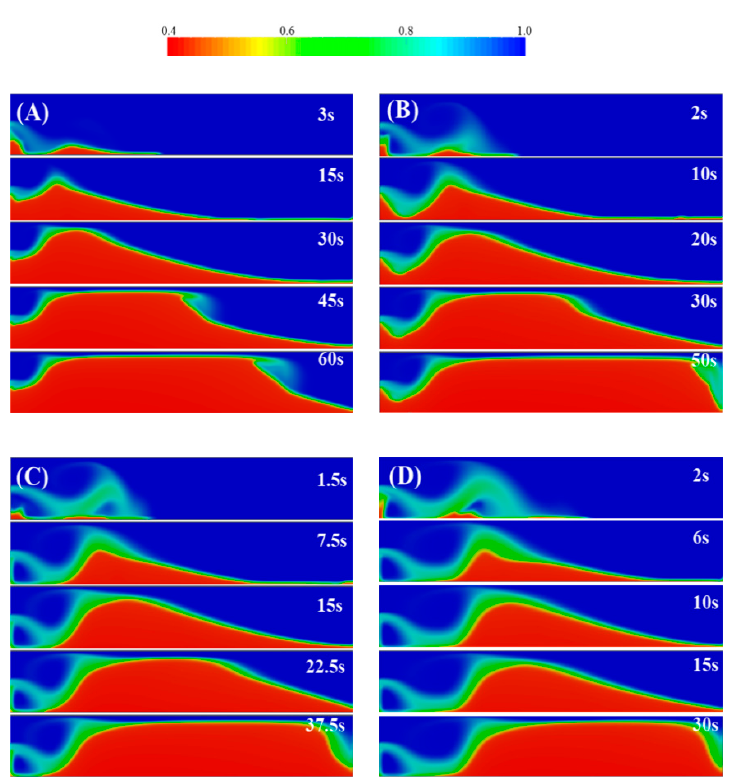
Figure 9. Volume concentration of liquid phase during the transport process for different injection A ) v = 2 m / s, ( B ) v = 3 m / s, ( C ) v = 4 m / s, and ( D ) v = 5 m / velocity cases: ( A ) v = 2 m/s, ( B ) v = 3 m/s, ( C ) v = 4 m/s, and ( D ) v = 5 m/s. velocity cases: (